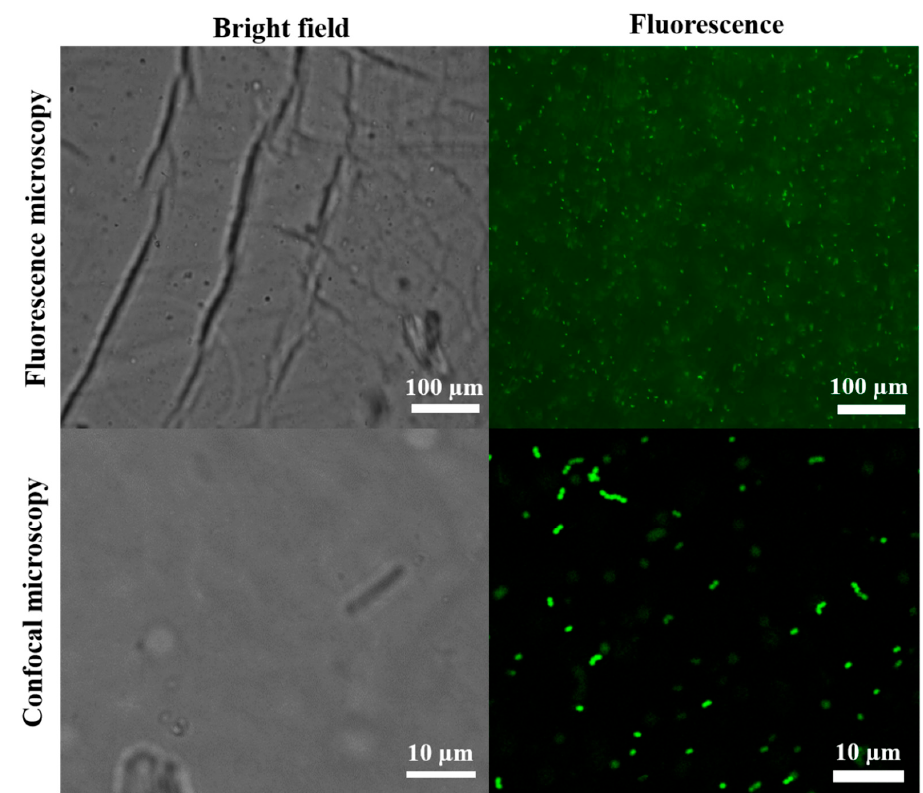
Figure 4. Fluorescence and confocal microscopy of wet alginate beads containing FITC-labelled FKC. The specimens were prepared by simply compressing wet alginate beads between slide glasses. EX: 492 nm, EM: 520 nm.